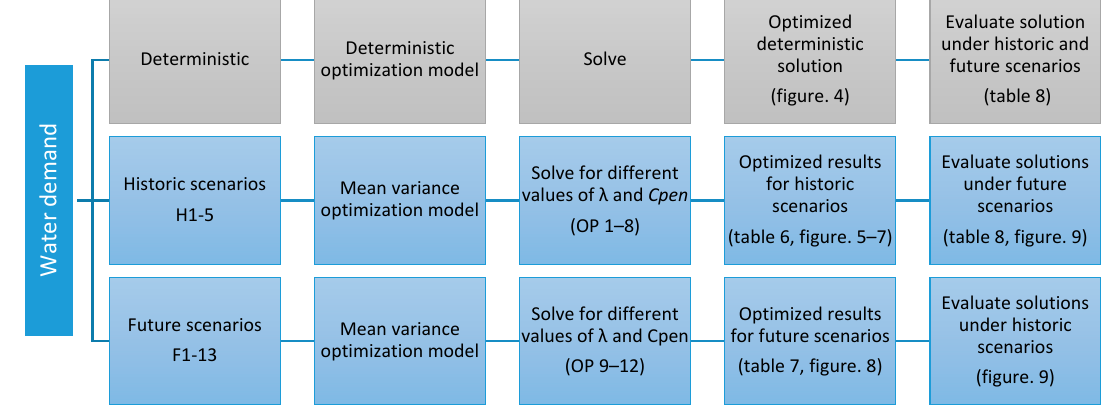
Figure 2. Flowchart illustrating the work process, from the generation of the water demand scenarios as inputs to the optimization models, the different considered optimization models, and lastly the computation and evaluation of different design